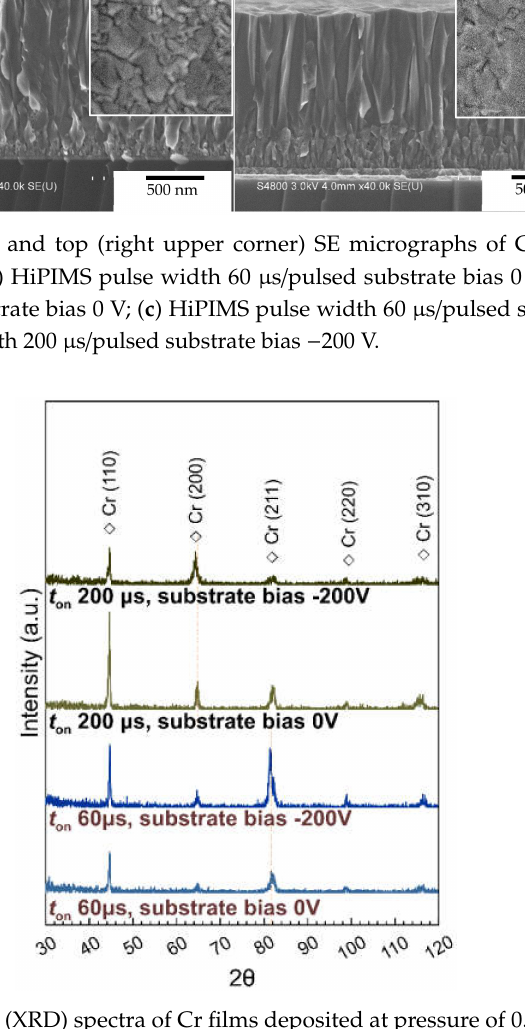
Figure 6. X-ray di ff raction (XRD) spectra of Cr films deposited at pressure of 0.8 Pa and 200 ± 10 ◦ C with di ff erent HiPIMS pulse widths ( t on ) and pulsed substrate bias